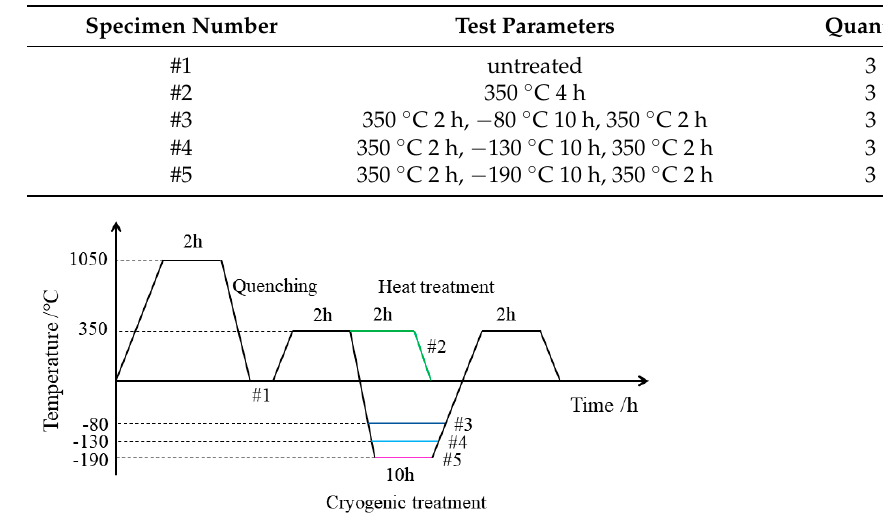
Figure 3. Schematic diagram of specimen cutting and clamping. Measuring contour. High-precision contour-measuring equipment was used to measure the deformation contour of the cutting surface. A contact CMM (Zeiss New Contura Vastxt) with a test error of 1.5 + L/360 μ m (L is the measurement length) and a step size of 0.2 mm was used to measure the contour of the cutting surface. (3) Data processing. The measured contour values of the two cutting surfaces were averaged and fitted to eliminate errors. Polynomial, sine, and cubic spline curves were applied for fitting. The fitting errors of the above three methods were compared and ana- lyzed with the original data. As shown in Figure 4a, the midline of the specimen section was taken along the length direction as the evaluation line. The squared variances of pol- ynomial fitting, sine curve fitting, and cubic spline curve fitting were 0.00158759, 0.00568631, and 0.000183585, respectively. Figure 4b shows the zoomed area in A of Figure 4a, from which it can be found that the curve from the cubic spline interpolation function had a better fit to the original measurement data. Therefore, the cubic spline interpolation function was chosen to fit the cutting surface contour. ( a ) ( b ) Figure 4. Fitted contour comparison of specimens. ( a ) Fitted contour comparison . ( b ) Amplifier of area A in Figure 4a. (4) Stress reconstruction. The fitted contour value was applied as the displacement boundary condition based on the principle of elastic superposition, and a finite element model was developed by using the deformed contour in the reverse direction. A finite element model of the sample after cutting was established by ABAQUS software